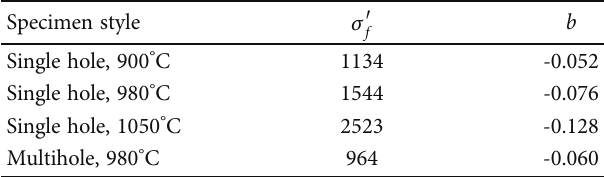
Figure 11: Fracture morphology of multihole Table 4: Parameters of the Basquin equation.